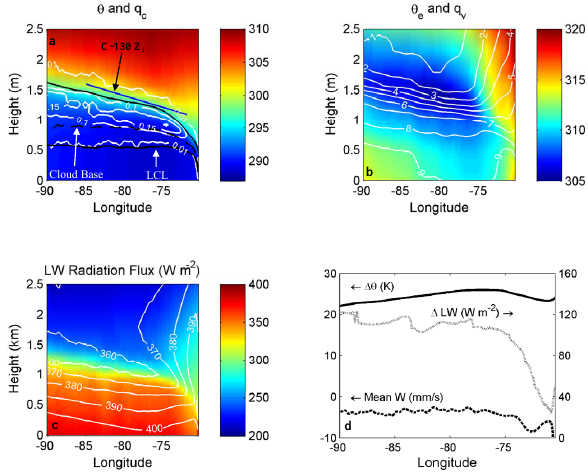
Fig. 9. COAMPS MBL variations along 20°S. (a) Longitude-height cross-section of q c (white contours in g kg -1 ) and θ (color shading in K). The mean predicted MBL height is denoted by the upper branch of black curve, the mean LCL by the lower branch of the black curve, mean cloud base by the black dashed curve. The blue line is the MBL height fitted by C-130 data. (b) cross sections of q v (white contours in g kg -1 ) and θ e (color shading in K); (c) cross sections of downward LW flux (color shading in W m -2 ) and upward LW flux (white contours); and (d) predicted longitudinal variations of the lower troposphere stability ( Δθ = θ 3km - θ SST , solid line in K), the time averaged vertical motion at the inversion height (dashed line in mm s -1 ) and the total LW divergence across the cloud layer ( Δ LW, dotted in Wm -2 ). Δ LW is defined as the difference between the total LW radiative flux just above clouds and that just below the cloud base.